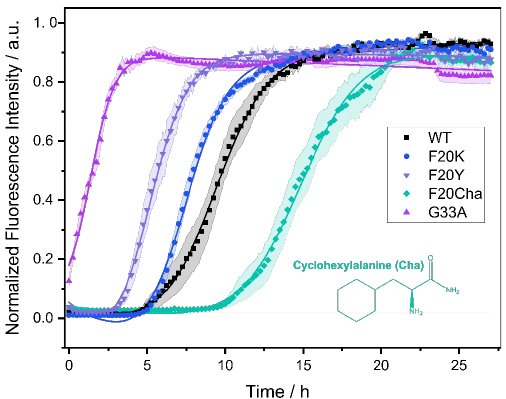
Figure 1. Fibrillation kinetics of A β 40 WT and the respective mutants recorded by the standard Thioflavin T (ThT) fluorescence assay. Solid lines represent best fit simulations according to equation. (1). The shaded areas represent the standard error of the mean. Intensity data measurements were carried out in three independent experiments in quintuplicate for each peptide. Experimental errors in the determination of the lag time and fibrillation time were calculated from fitting errors.